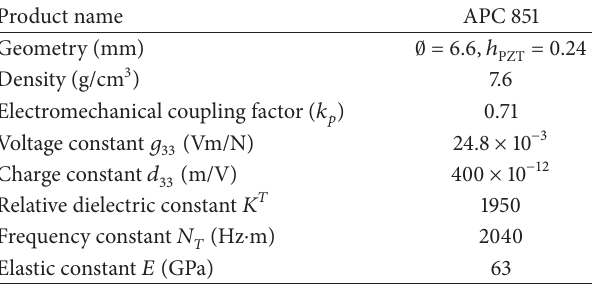
Figure 4: A typical structure partitioned to some same size semicircular areas. Table 1: Material properties of PZT transducer.